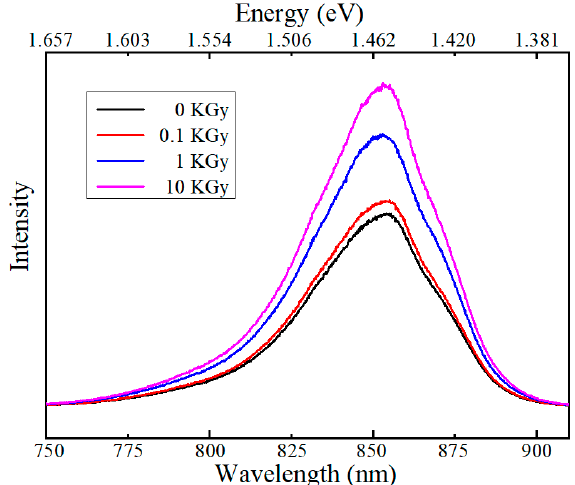
Figure 5. The photoluminescence spectrum of GaAs at room temperature under different gamma irradiation doses (0, 0.1, 1 and 10 KGy).